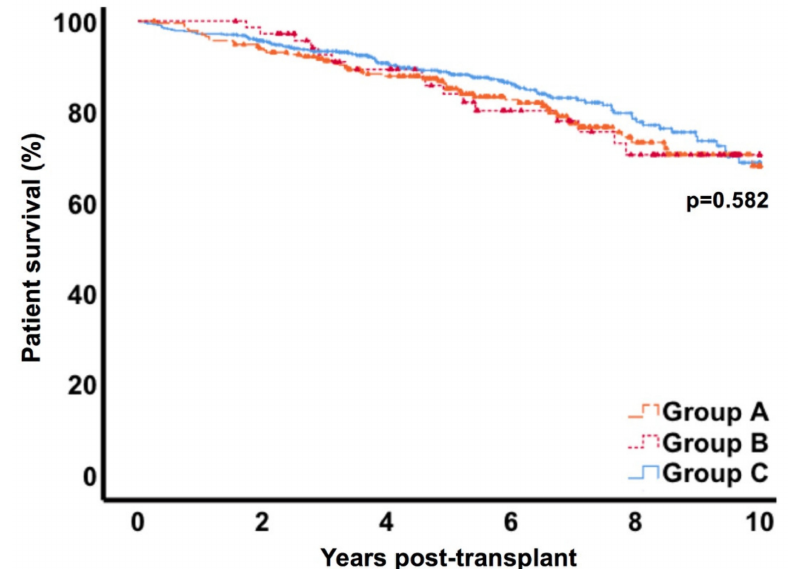
Figure 4. Patient survival. * Group A = lymphocele conservatively monitored; Group B = lymphocele with intervention; Group C = control.